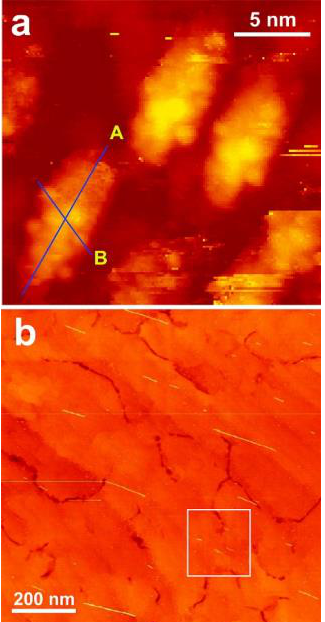
Figure 3. Scanning tunneling microscopy (STM) images of DNA-CNT hybrids deposited on p-doped Si(110) surface. ( a ) 21 nm × 21 nm scanning area; ( b ) 1 μm × 1 μm scanning area. For preparation of